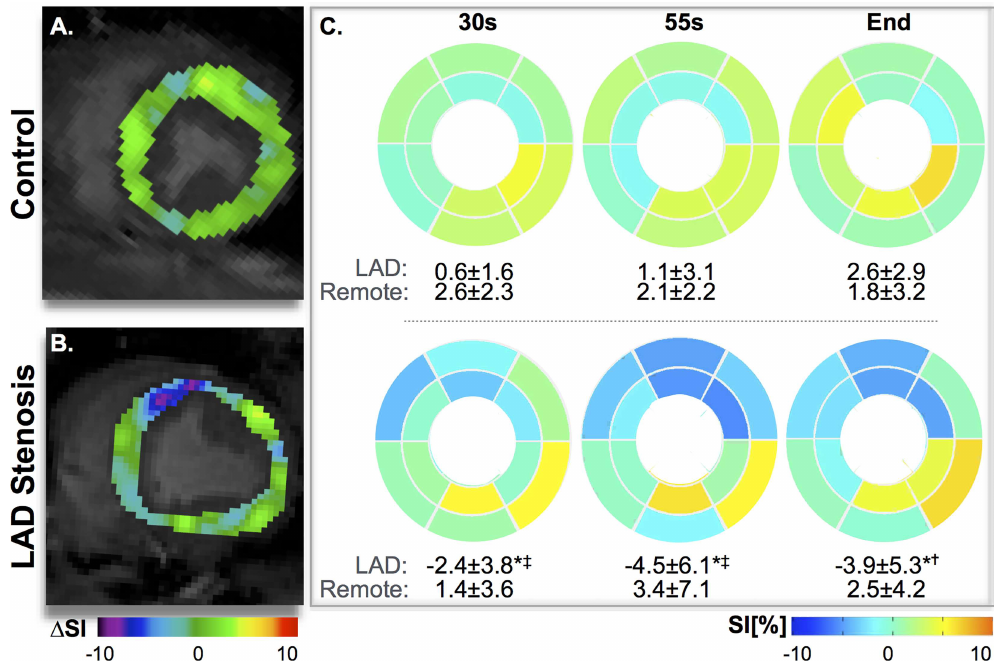
Fig 4. Segmental changes of myocardial oxygenation during the HVBH. Subtraction images (smoothed using a 6mm Gaussian filter) demonstrate that at the 30s, SI increasedhomogeneouslyin the control animal (A), while there was a decrease in the territory of the stenosed LAD (B). The mean response for each segment from all animals similarly shows that in control animals (top row, n = 8), Δ SI[%] is consistently larger for all segments, whereas for the stenosis animals (bottom row, n = 10) in the LAD regions a significant decrease is already observed at 30s, and this continuesthroughout the breath-hold. ( * p < 0.05 between LAD and remote territory within the group, † p < 0.05, < 0.05‡ p < 0.01 for the difference in LAD response between